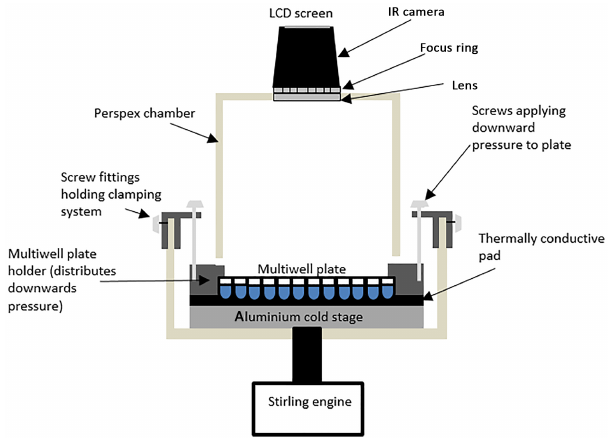
Figure 1. Schematic diagram of the IR-NIPI system (not to scale). The IR camera is positioned above the multiwell plate and monitors the freezing events as the cold stage